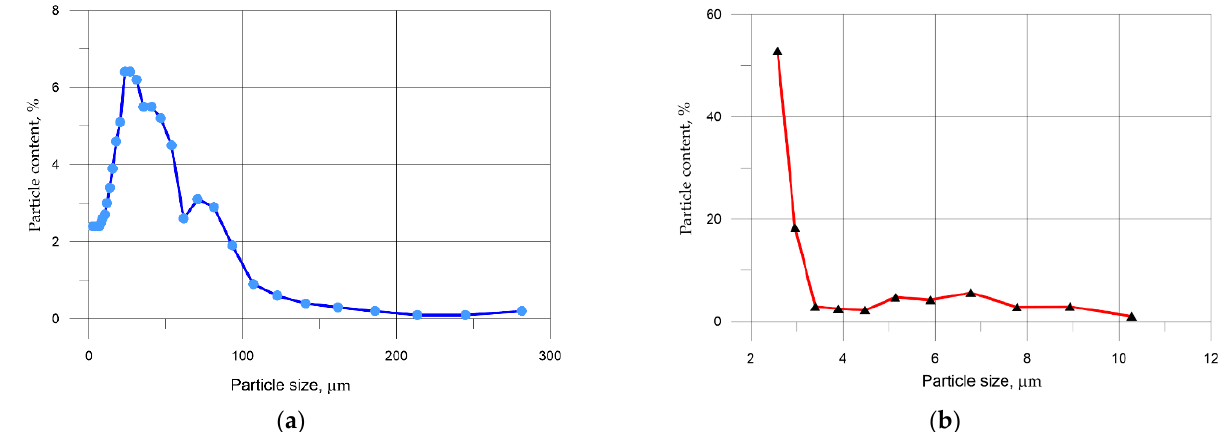
Figure 5. Particle size distribution of ( a ) Portland cement, ( b ) micro silica particles.